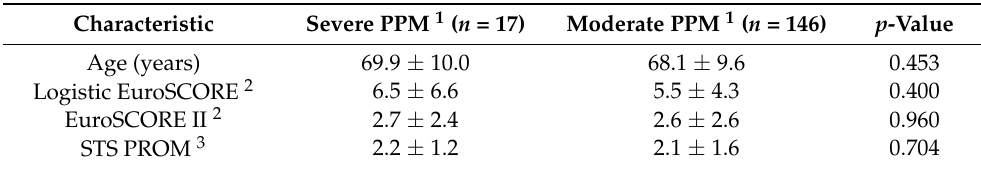
Table 4. Baseline characteristics of the patients with severe PPM vs. those with moderate PPM. Characteristic